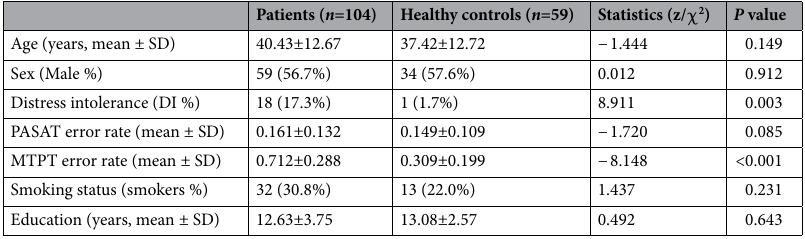
Table 1. Participant demographics and clinical characteristics PASAT Paced auditory serial addition task, MTPT Mirror-tracing persistence